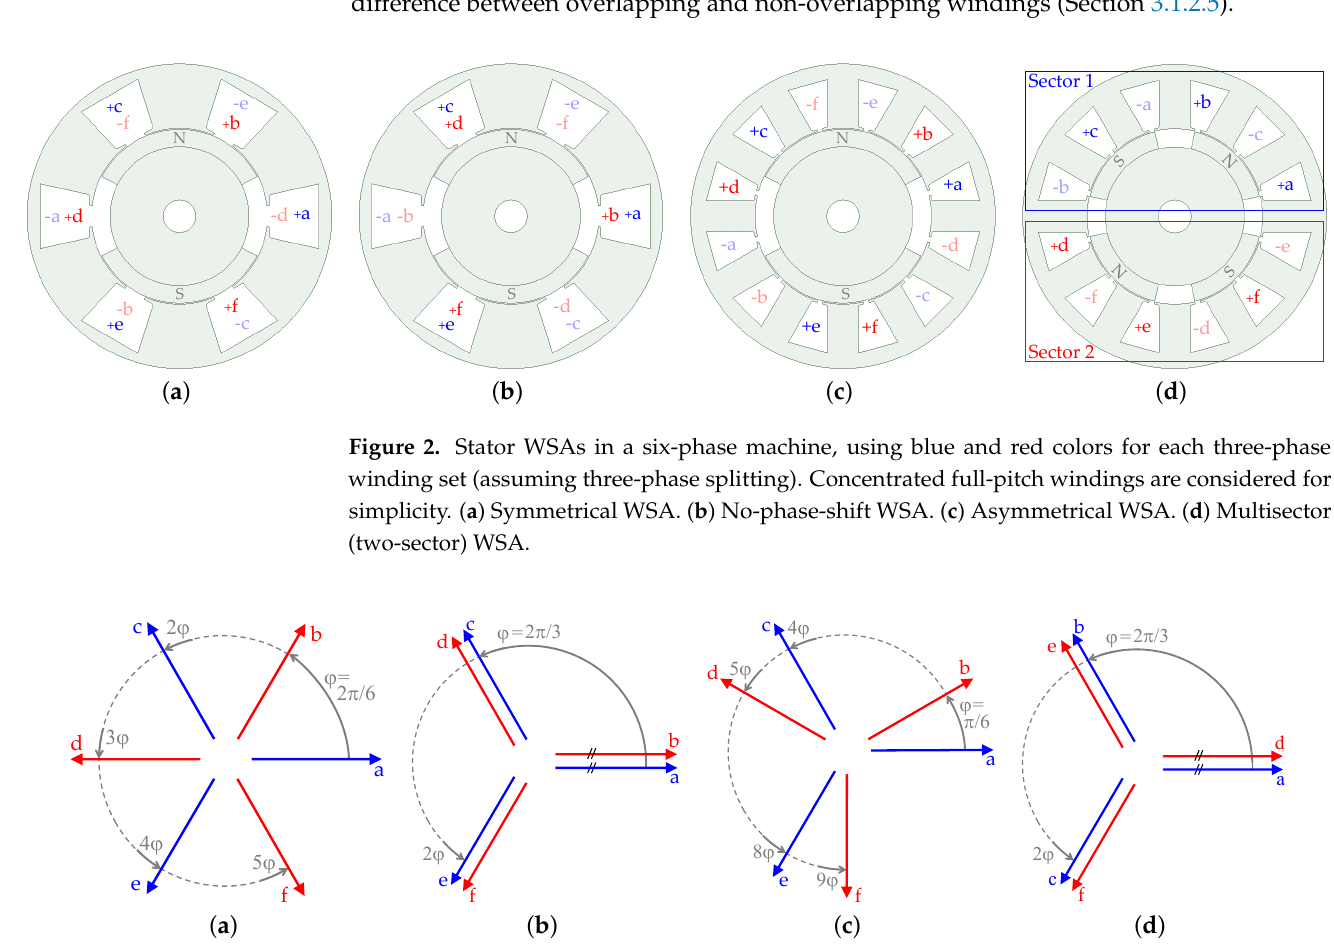
Figure 3. Phasor representation of phase angles with respect to time corresponding to different stator WSAs in a six-phase machine (cf. Figure 2). These diagrams are also valid with respect to space for all WSAs except multisector WSA. ( a ) Symmetrical WSA. ( b ) No-phase-shift WSA. ( c ) Asymmetrical WSA. ( d ) Multisector (two-sector)